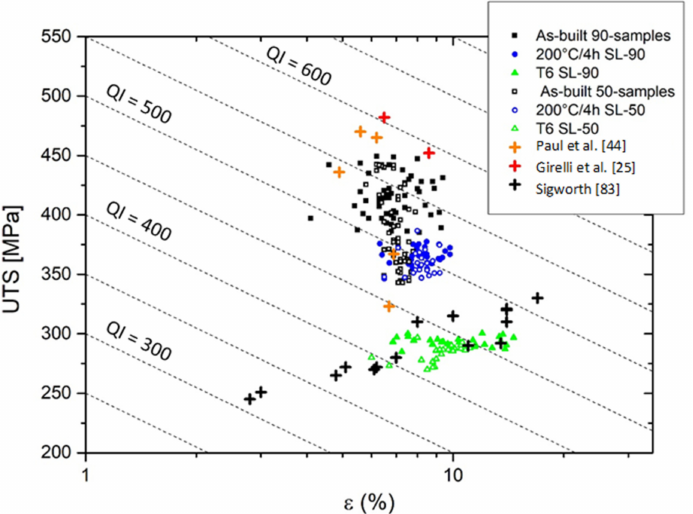
Figure 11. Comparison of mechanical properties of AlSi10Mg SLM in as-built and heat-treated conditions through the Quality Index (QI) with the results shown in the